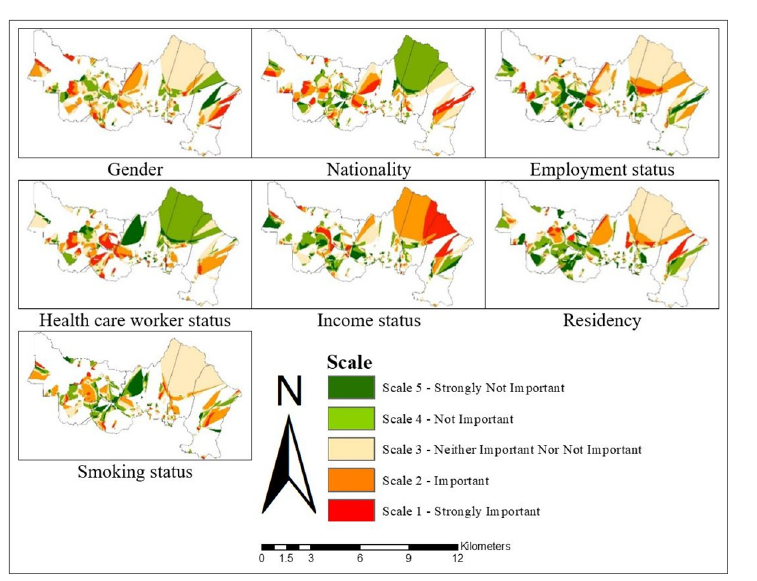
Fig 8. Spatial varying local coefficient estimated for GWR1 in Gombak, 2013 to 2017. https://doi.org/10.1371/journal.pone.0252146.g008 follows: gender (east-south-east and from north-north west to west, and south-south-west), nationality (east-south-east, centre, north-north-west, and west to west-south-west), employ- ment status (north, centre, and west-south-west), health care worker status (from west to south, and east-south-east), income status (from north-east to east, north-north-west, and west-north-west), residency (from centre to east, north, north-north-west, and west-north- west), and smoking status (east-south-east, centre, and west-north-west). In overall, income status showed the largest areas for the highest spatial varying local coefficient values while health care worker status exhibited the largest areas for the lowest spatial varying local